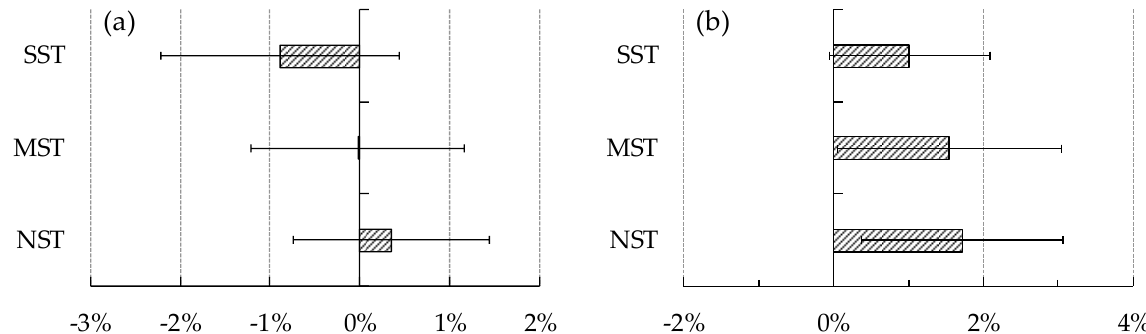
Figure 7. Effect of solar radiation on double rice yield. ( a ) early rice; ( b ) late rice. NST, MST and SST indicate the northern subtropical zone, middle subtropical zone and south subtropical zone, respectively. (early rice: R 2 = 0.293, p = 0.0456; late rice: R 2 = 0.401, p < 0.001, n = 66).